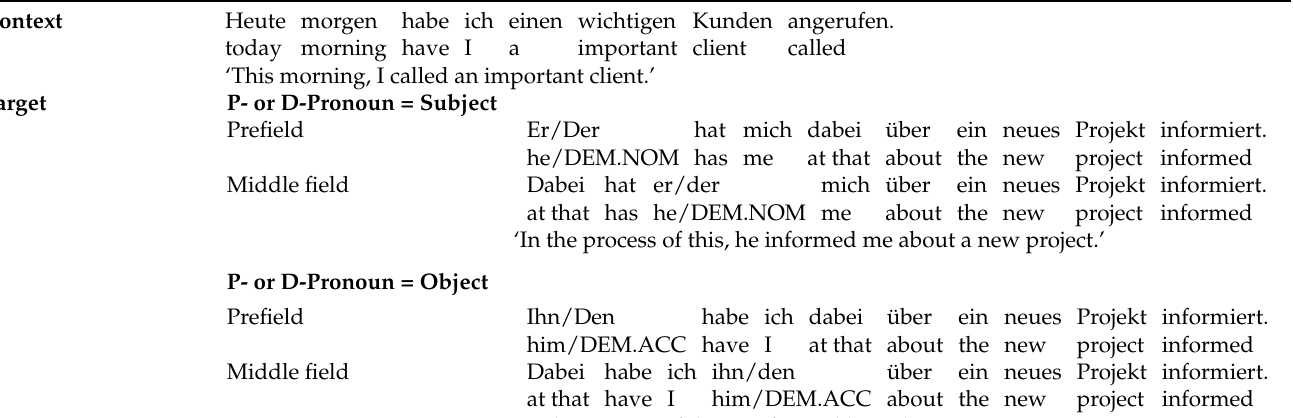
Table 5. Stimulus sentence from Experiment